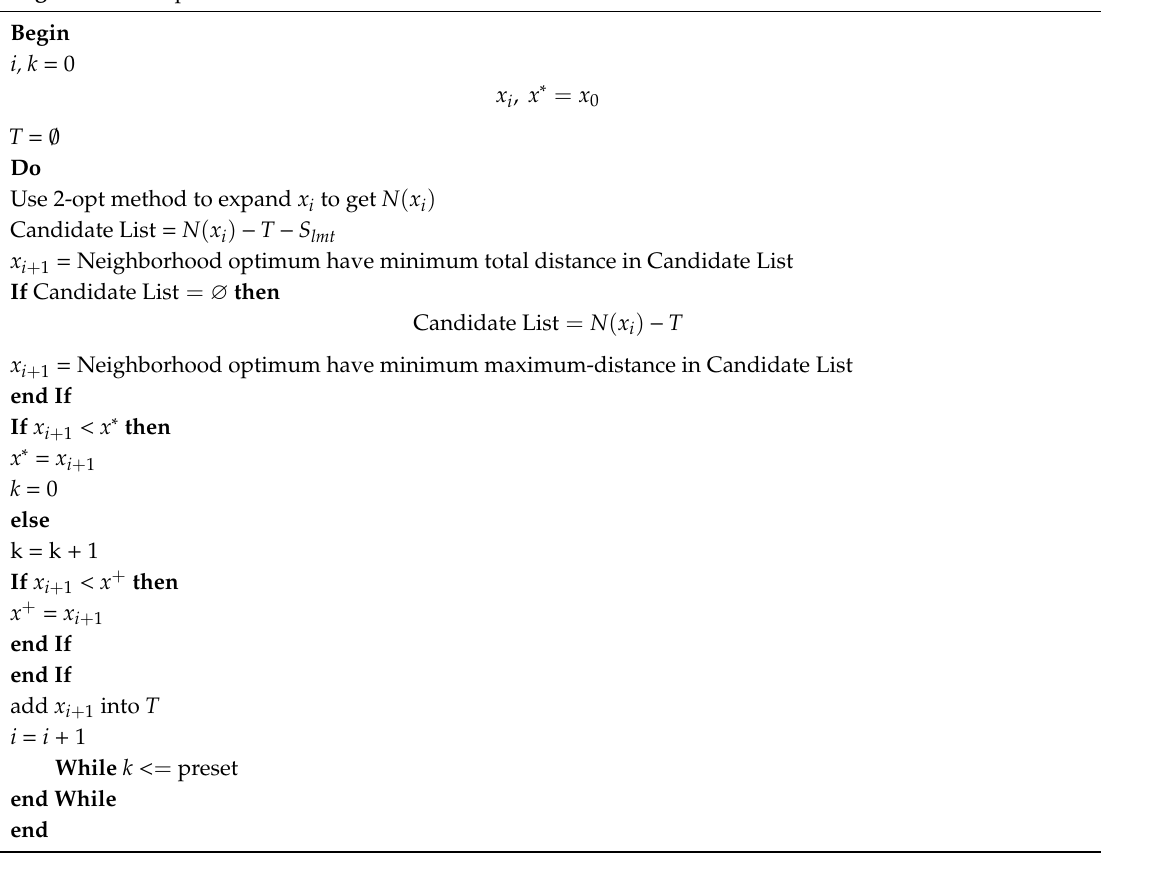
Algorithm 1. Improved Tabu Search Pseudo